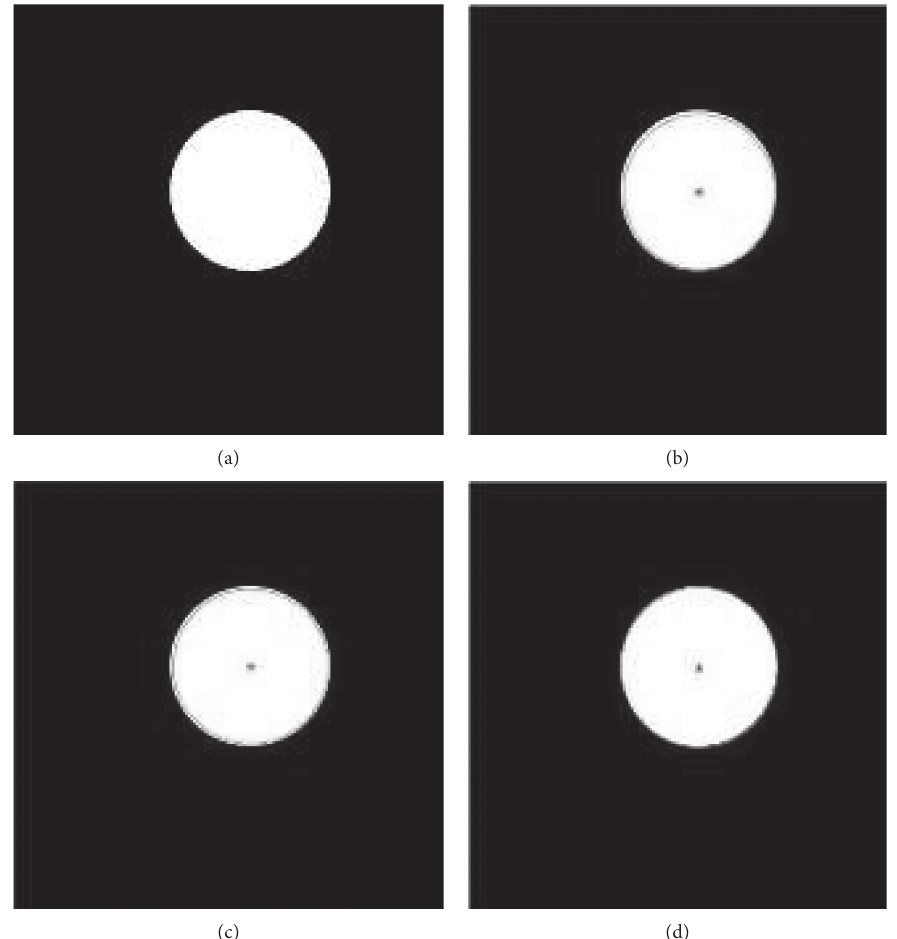
Figure 7: Round edge detection results. (a) Computer-generated image. (b) Random Hough transform algorithm. (c) Gradient symmetry algorithm. (d) This algorithm detects images.